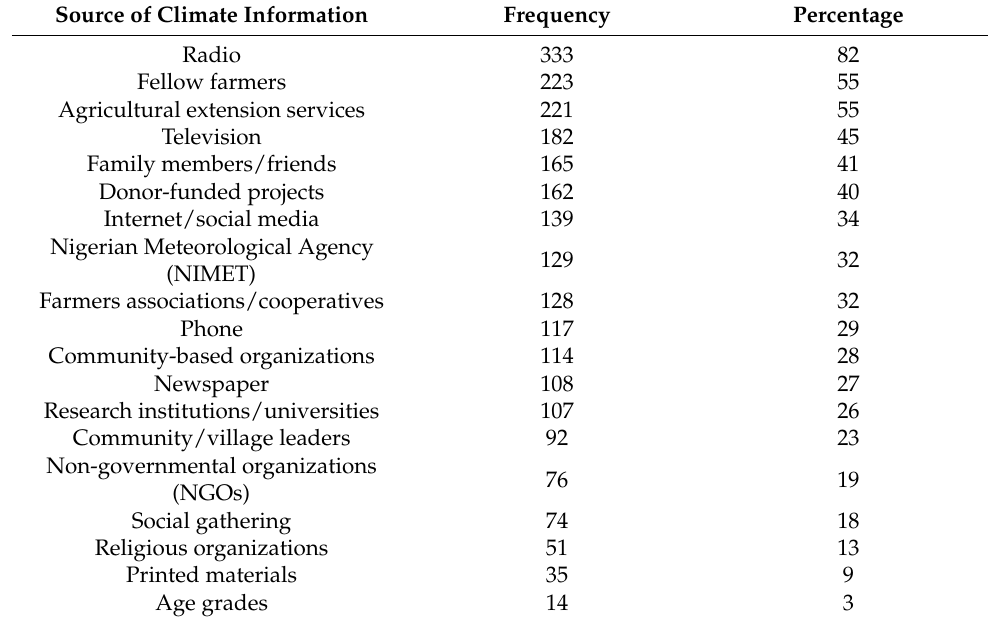
Table 1. Frequency distribution of farmers according to sources of climate information.